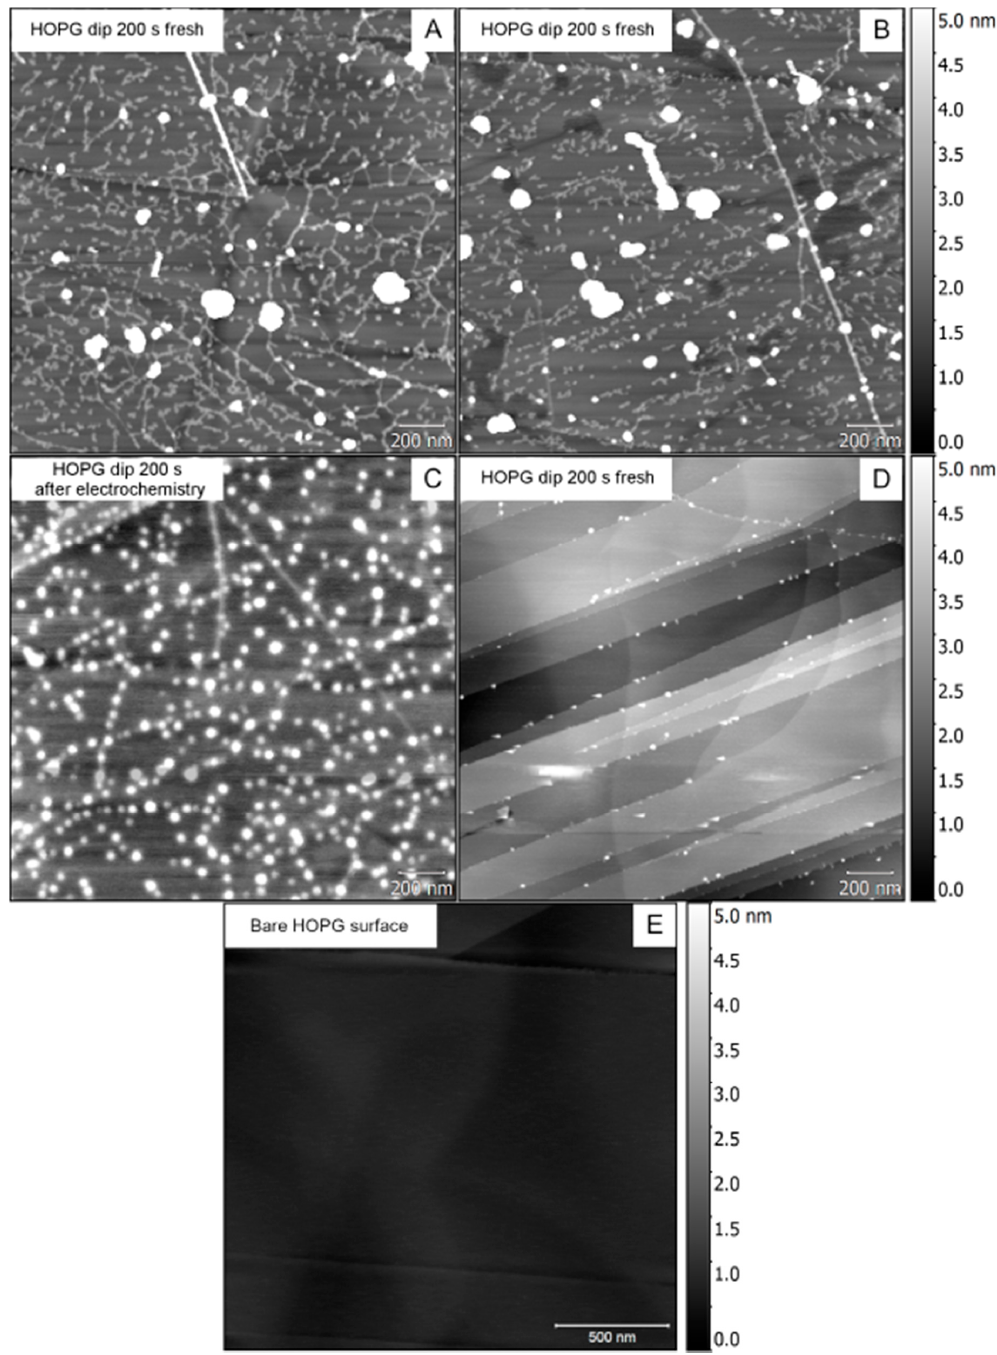
Figure 6. Atomic force microscopy (AFM) images of HOPG surfaces immersed in a Pt deposition solution (3 mM H 2 PtCl 6 , 0.5 M NaCl, pH 2.3) recorded after the immersion ( A , B and D fresh)